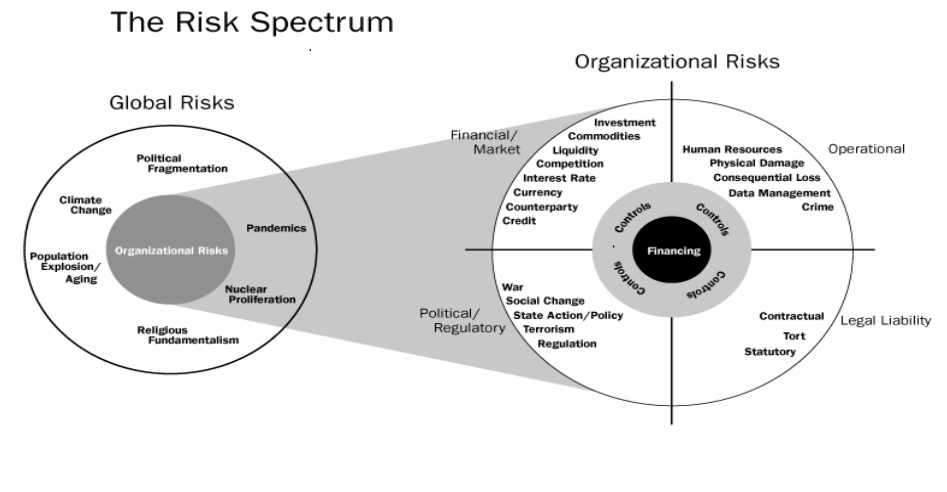
Source: Adapted from Kloman